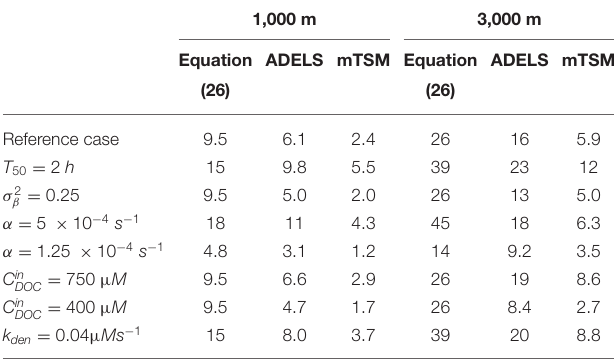
TABLE 2 | Percent of nitrate removed at 1,000 and 3,000 meters for the ADELS and mTSM